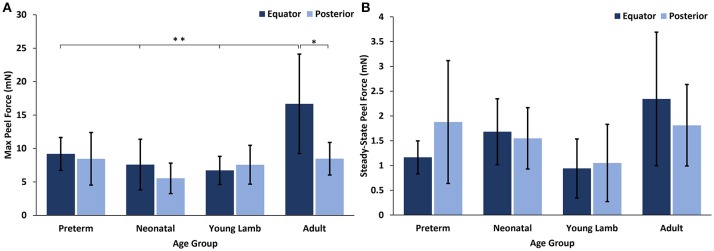
(A) Maximum and (B) steady-state peel forces for each sheep age group and region. Error bars indicate standard deviation from the mean (*p = 0.0016 and **p < 0.0001).